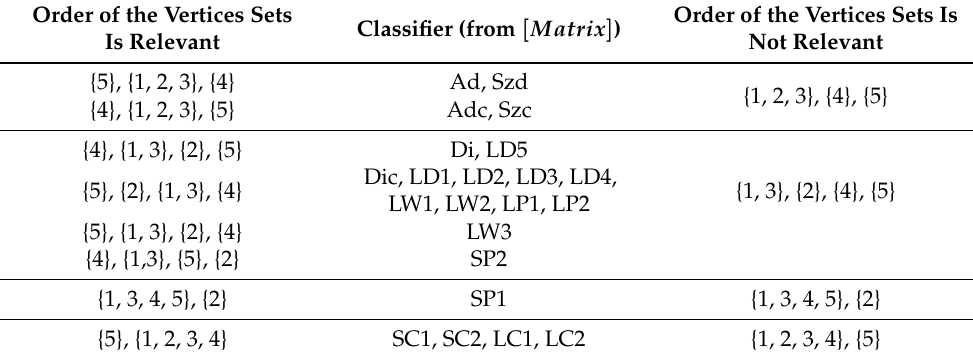
Table 10. Different partitions of vertices for Figure